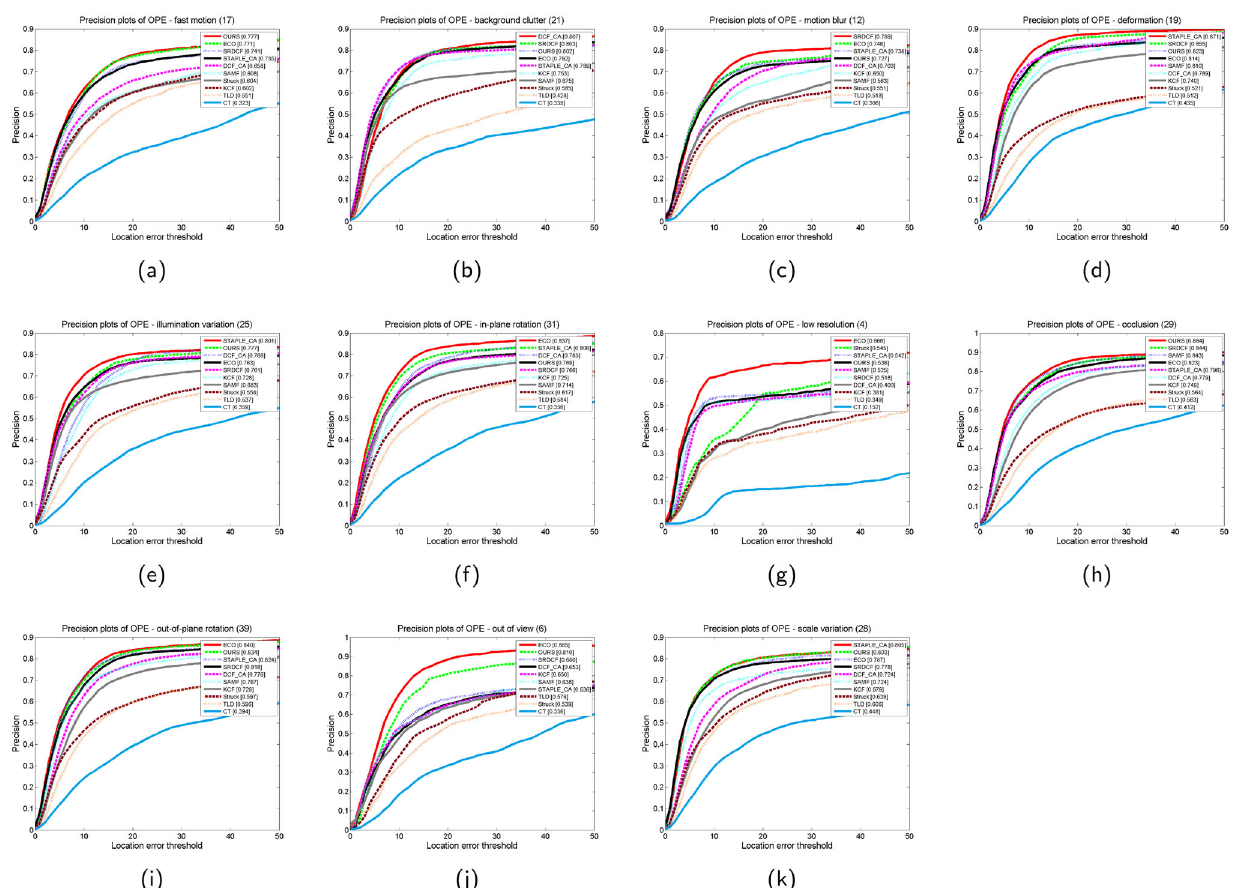
Fig. 7 Accuracy score curve of 11 algorithms on an OTB-50